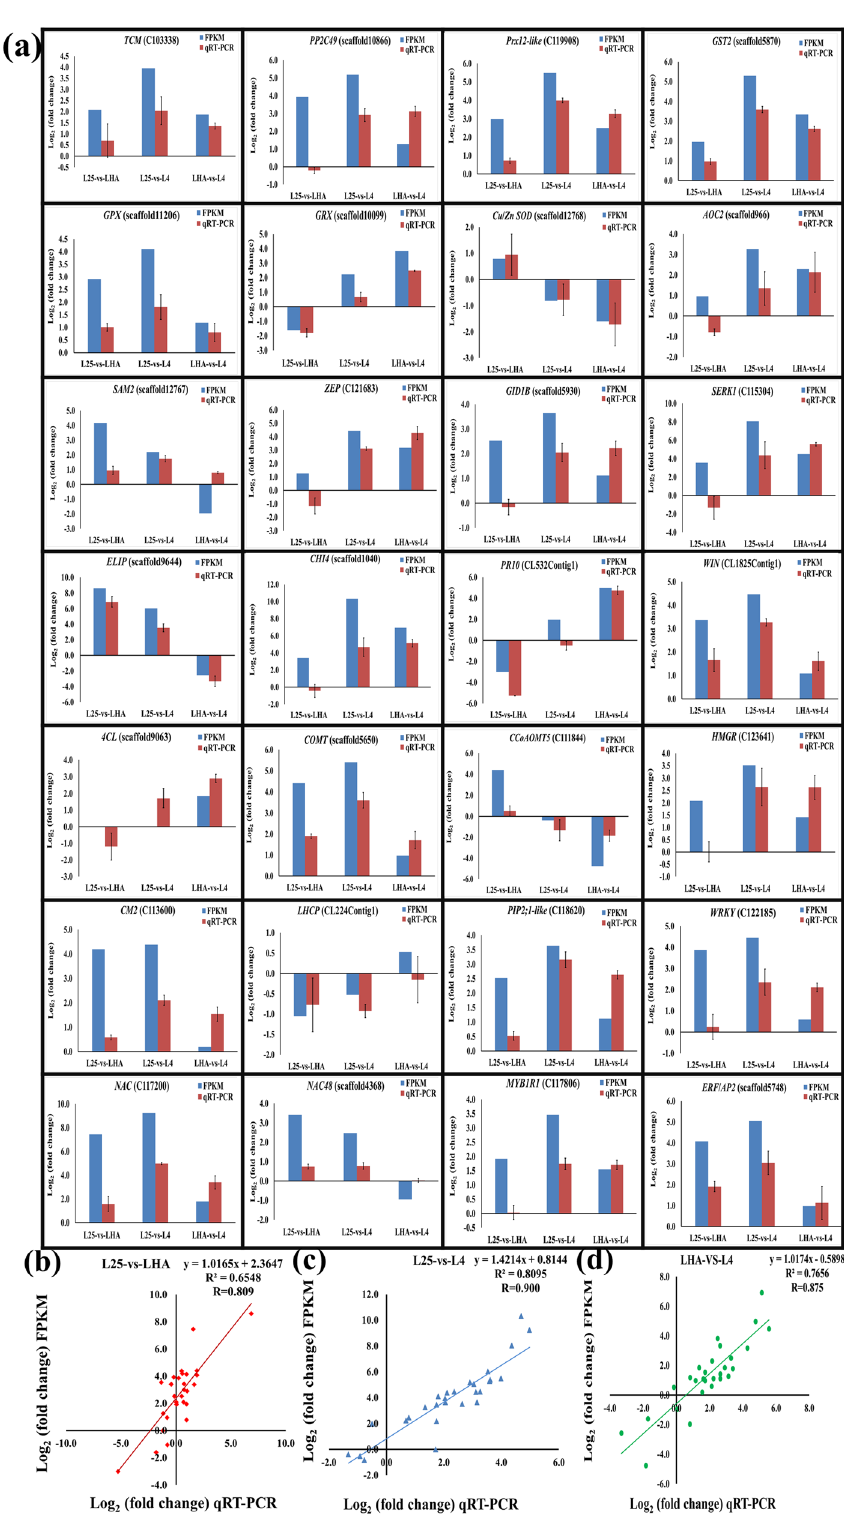
Figure 5. Validation of differentially expressed genes (DEGs) and correlation of gene expression. (a) Validation of FPKM based relative expression of 28 DEGs by qRT-PCR. X-axis indicates the conditions of the comparisons viz. L25-vs-LHA, L25-vs-L4, and LHA-vs-L4, whereas y-axis indicates the log 2 fold change values of DEGs based on FPKM and qRT-PCR. Pearson correlation coefficient (R) was calculated between log 2 fold change values of qRT-PCR (x-axis) and FPKM (y-axis) for (b) L25-vs-LHA, (c) L25-vs-L4, and (d)